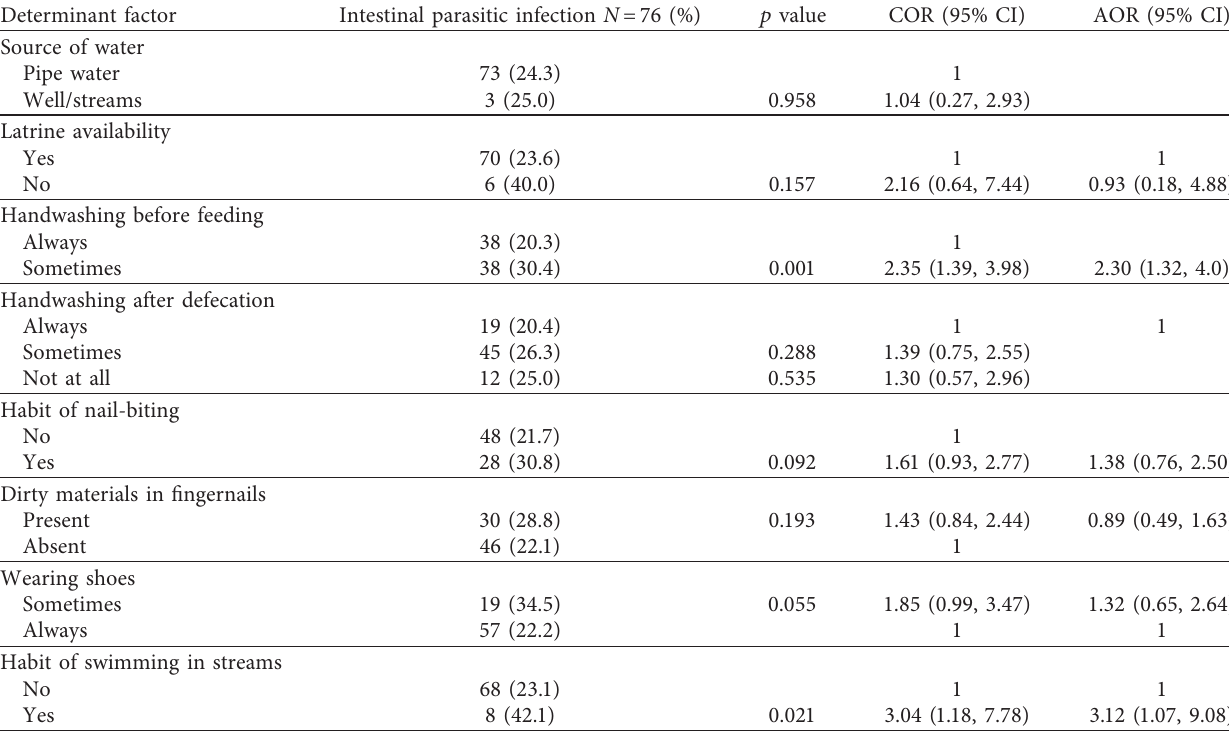
Table 4: Association of environmental and behavioral determinant factors with the prevalence of intestinal parasites among schoolchildren in Rama town, Northern Ethiopia, June